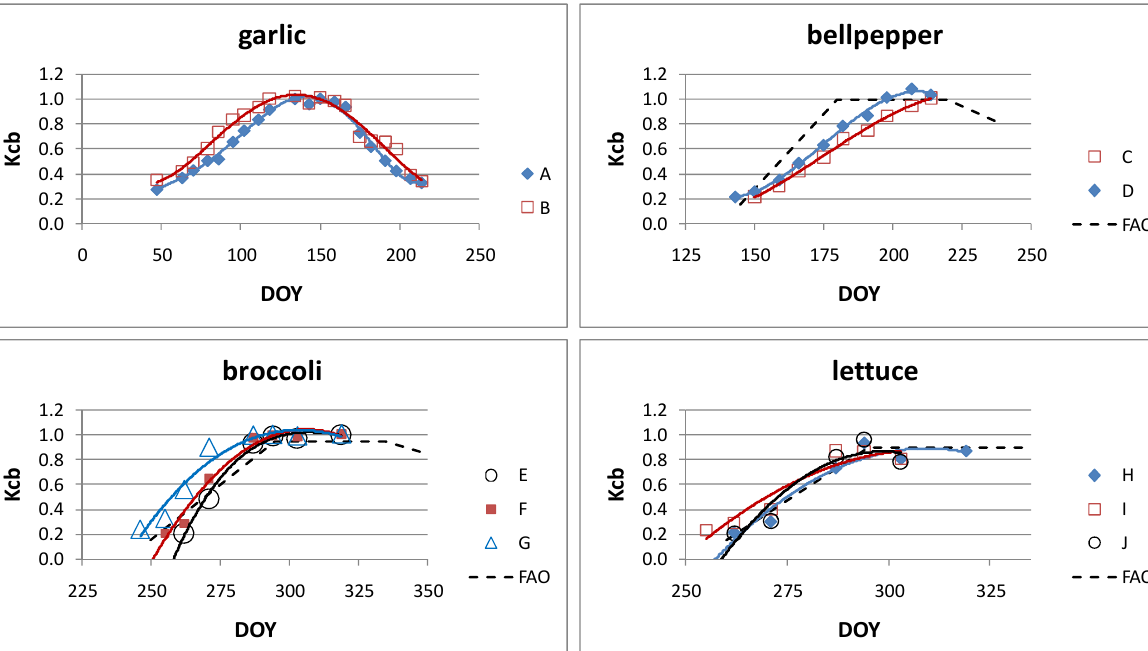
Figure 7. Landsat based time-series of Kcb for four different crops, with trendlines. Letters represent fields of Table 2. Dashed line is planning guideline for crop development, mid-season, and late-season stages from FAO-56 Tables 11 and 17 [4] as available (FAO does not provide stage duration for garlic.). FAO development stage start dates were roughly aligned with observed dates for comparison